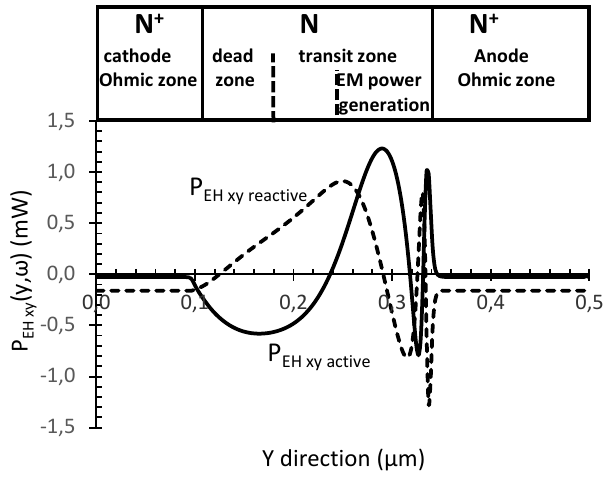
Figure 16: Y direction spatial evolution of the local EM power at the fundamental frequency ω at x=130 µm The cathode and anode ohmic zones behaves as RF loss regions. Indeed, the slightly negative value of the local active EM power indicates that the RF EM field provides EM energy to the drifting electrons. The N active region split in two subzones. In the first one, P EHxy active is clearly negative. The first one corresponds to the “dead zone” where the electrons gain the threshold energy from the electric field leading to the inter-valley transfer phenomenon and electron accumulation layer development. The second zone corresponds to the transit zone where the drifting electron layer contributes to the RF EM energy generation. However, only the zone where P EHxy active is positive really contributes to the EM power generation. Note that the sudden space variations at the N active zone/N + cathode interface result from the strong modulation of the high field depleted zone width under the action of the y direction RF EM electric field component E RFy .